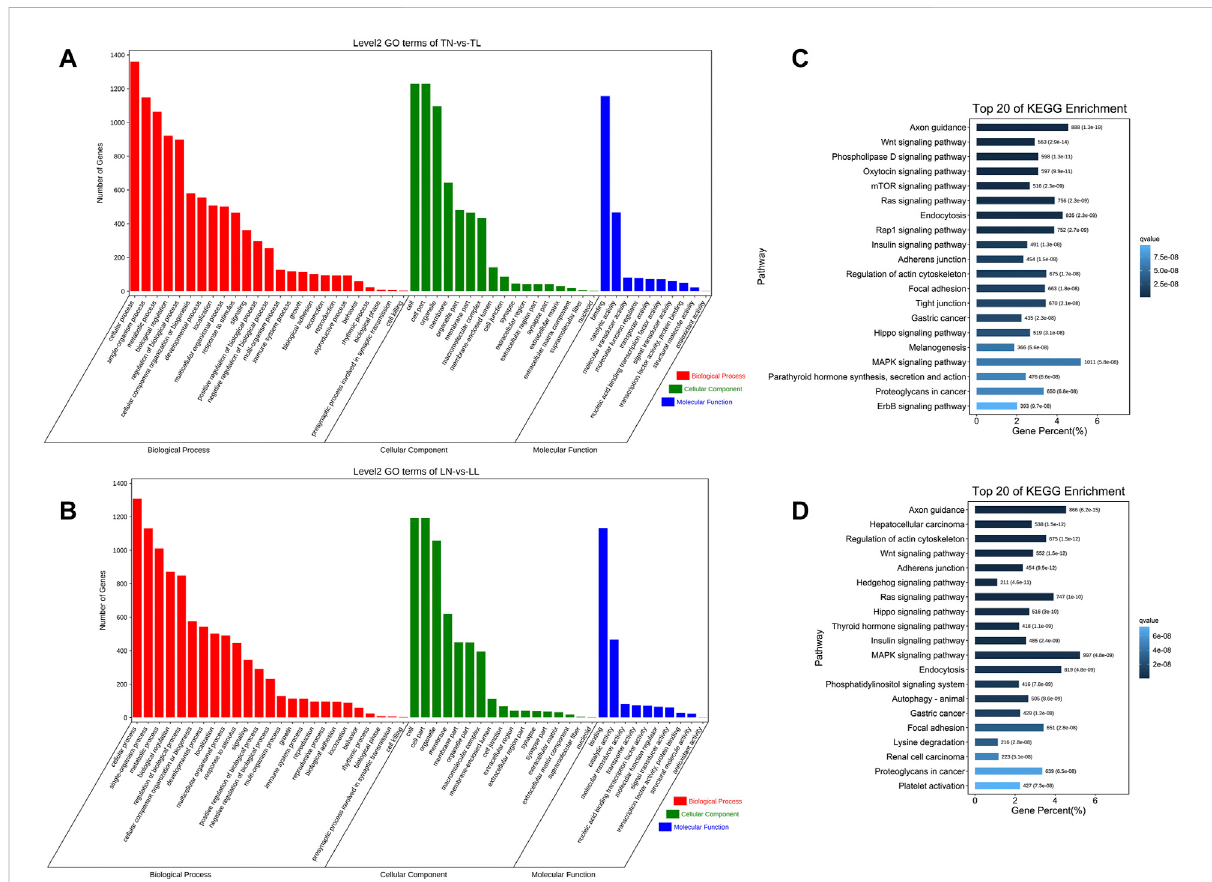
FIGURE 5 Functional annotation analysis of the target genes of DEmiRNAs. (A) GO annotation of the target genes of DEmiRNAs between TN and TL groups. (B) GO annotation of the target genes of DEmiRNAs between LN and LL groups. (C) KEGG enrichment of the target genes of DEmiRNAs between TN and TL groups. (D) KEGG enrichment of the target genes of DEmiRNAs between LN and LL